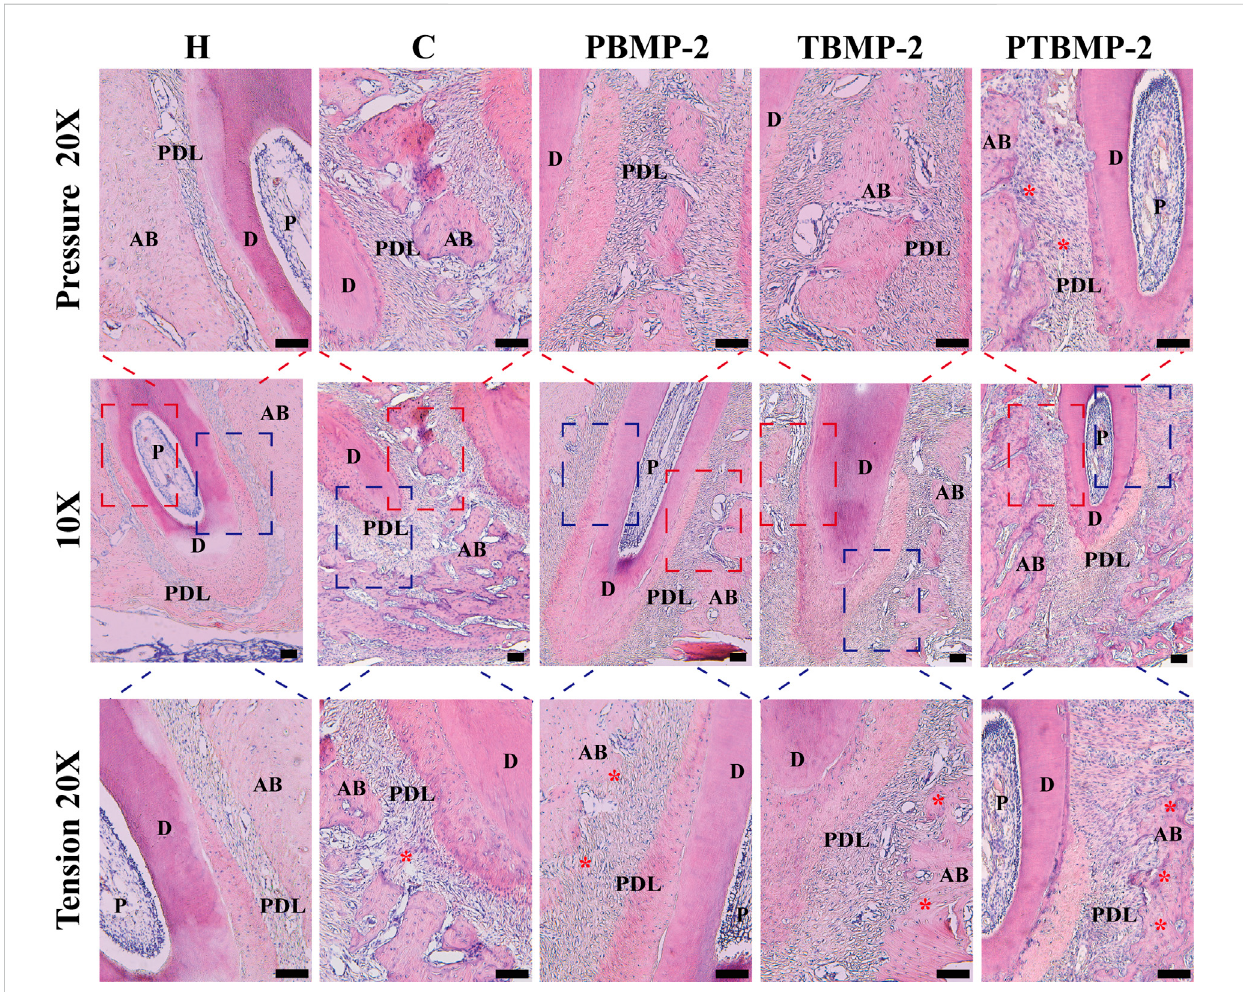
FIGURE 6 Light micrographs of sagittal hematoxylin-eosin (HE) stained sections of the mesial root of left maxillary fi rst molar (M1) in ×10 magni fi cation and ×20 magni fi cation on the pressure and tension sides. Red boxes, periodontal tissue of pressure side; blue boxes, periodontal tissue of tension side. Scale bar = 100 μ m. AB, alveolar bone; D, dentin; PDL, periodontal ligament; P, dental pulp. *, new bone